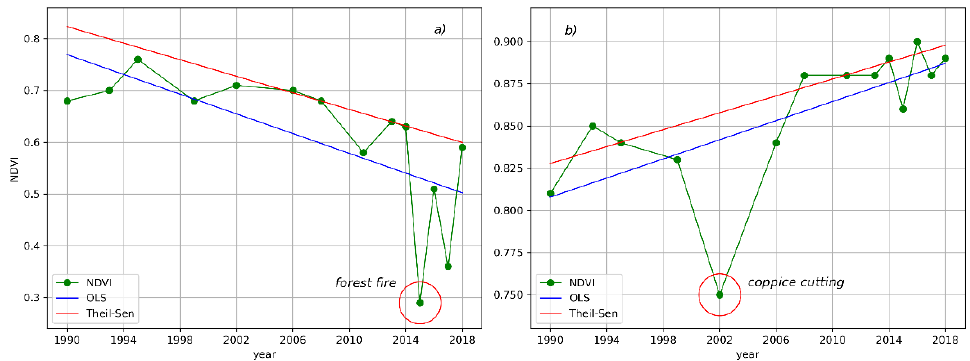
Figure 11. Comparison between the slope trends of NDVI time series (1990–2018) calculated with OLS (blue line) and Theil–Sen estimators (red line) of two sampled points near: ( a ) Montegrosso-Pallareta, ( b ) Aia dei Monaci.